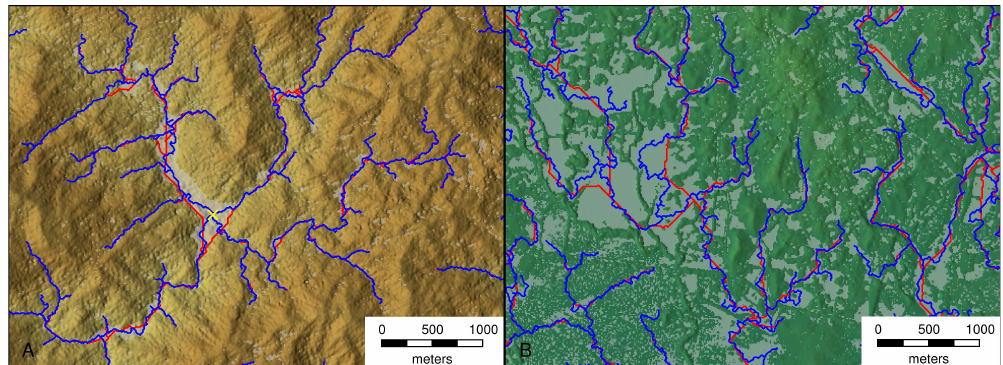
Fig. 9. A typical example for the impact of sink filling along a section of a river course extracted from the 30m SRTM DEM. Along this section, 92% of all elevation values were modified. Parts of the river course obscured by trees are highlighted in the GoogleEarth sreenshot.